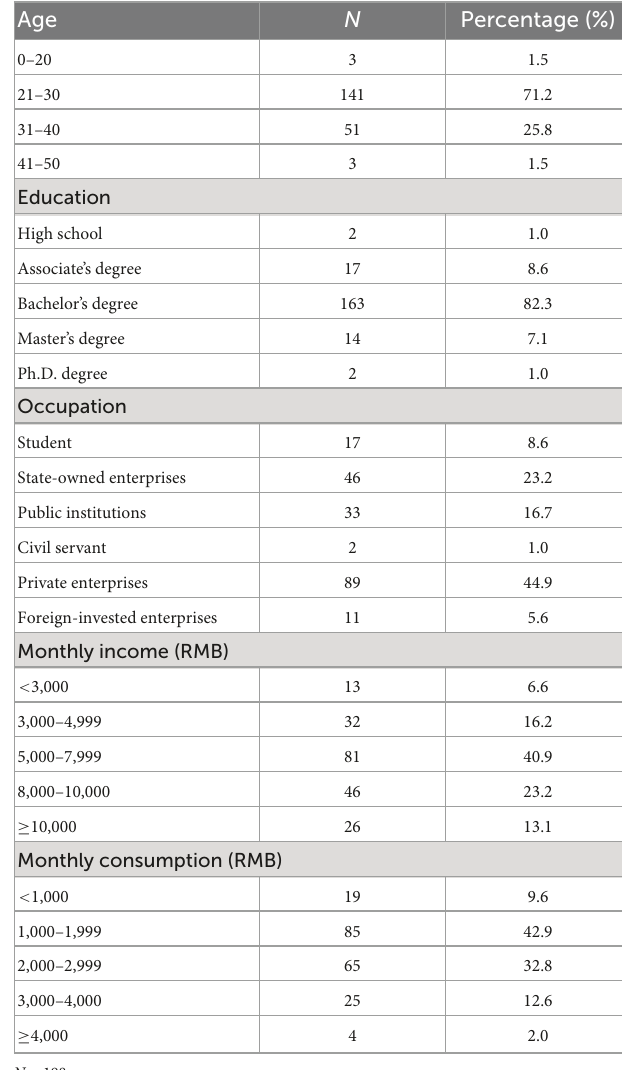
TABLE 1 Description of participants’ demographics in Study